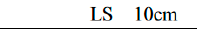
Figure 9. Structure of the pavement. CTB: cement treated base; LS: lime-stabilized soil; SG: subgrade.